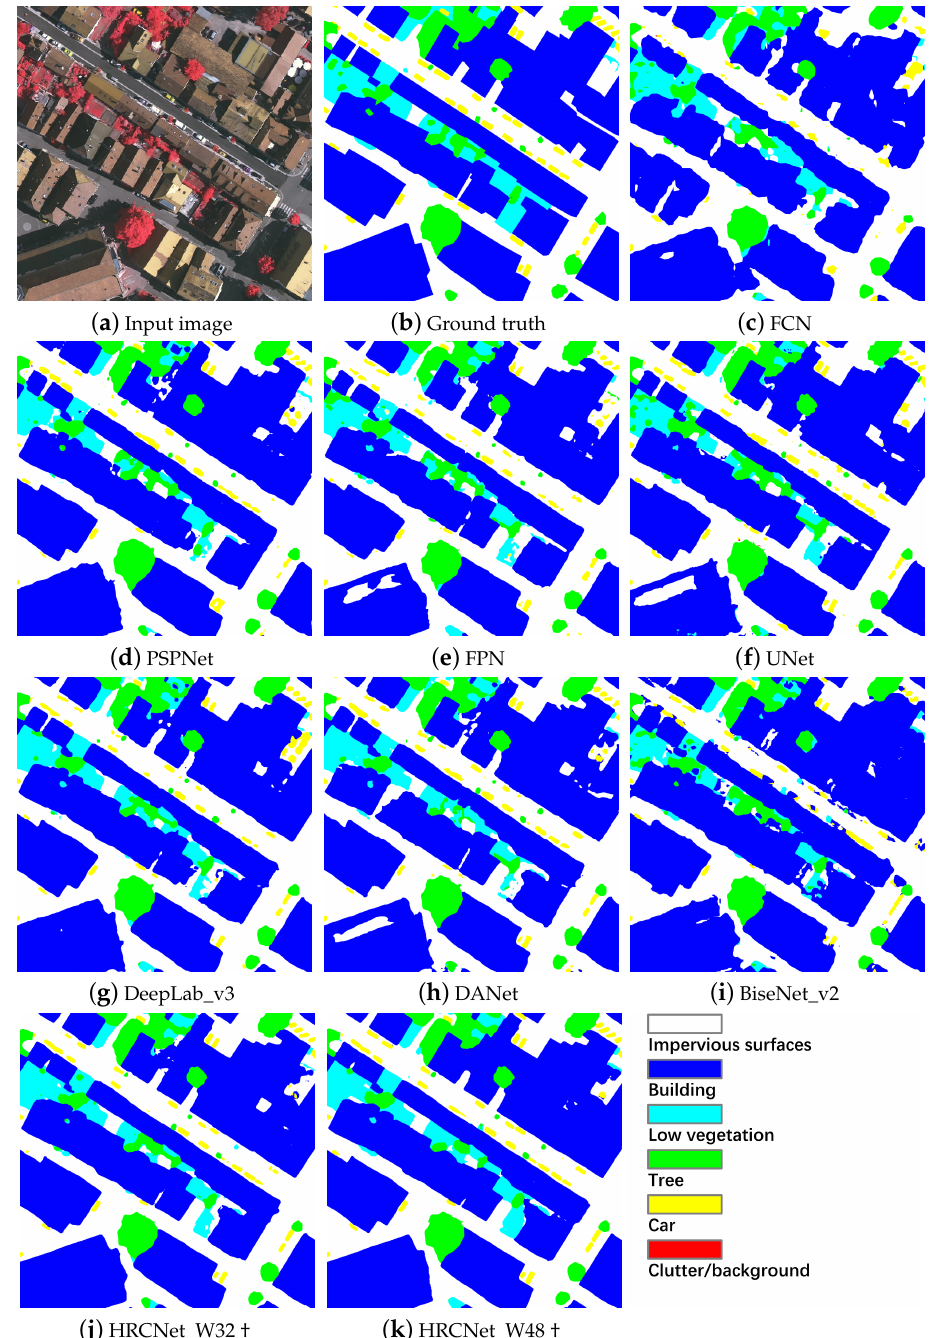
Figure 11. The prediction maps of the above methods on the Vaihingen dataset. “†” means using data augmentation (Flip and MS testing)